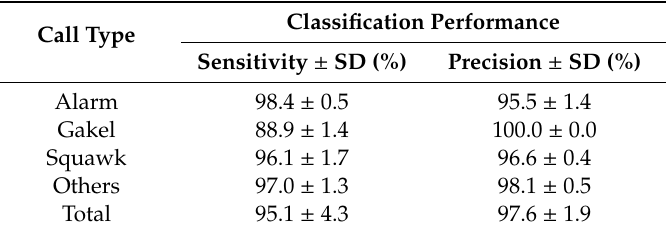
Table 4. Classification performance of the SVM